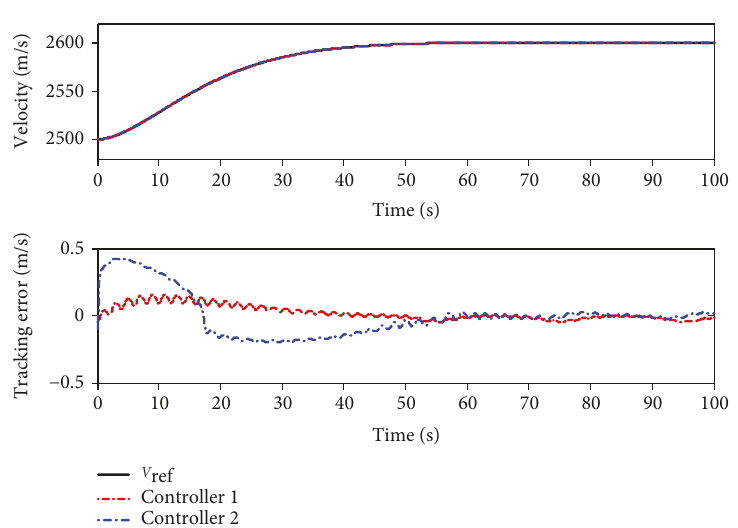
Figure 2: Velocity tracking